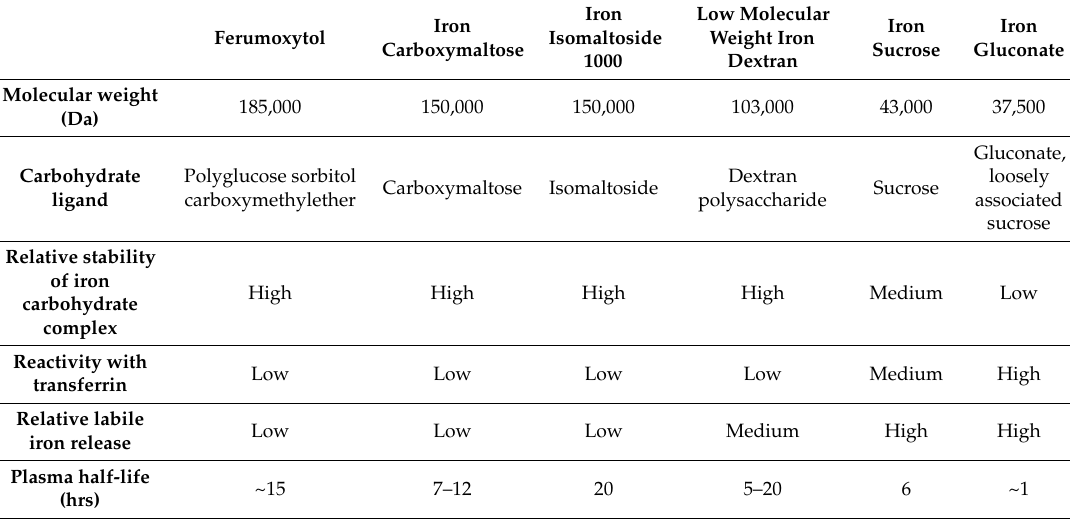
Table 3. Comparison of physicochemical characteristics and pharmacokinetics of IV irons